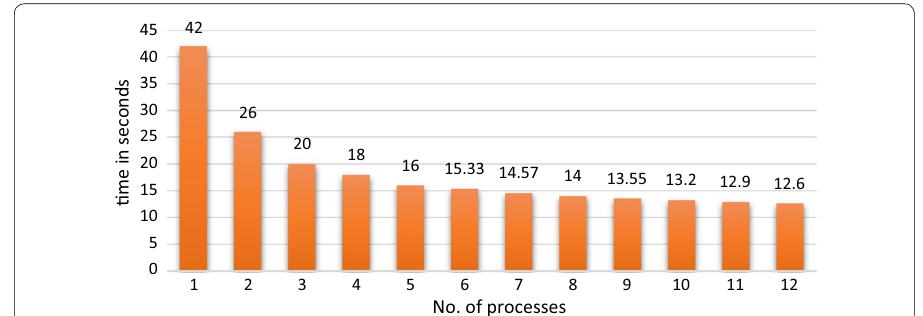
Fig. 10 Execution time (s) for AES encryption program using